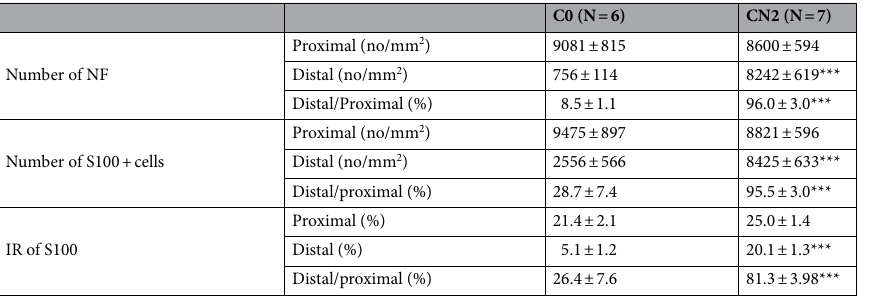
Table 4. Immunohistochemical evaluation of axonal outgrowth, number of S100 positive cells and immunoreactivity of S100 in the proximal and the distal nerve segment in 16 weeks after the implantation. NF